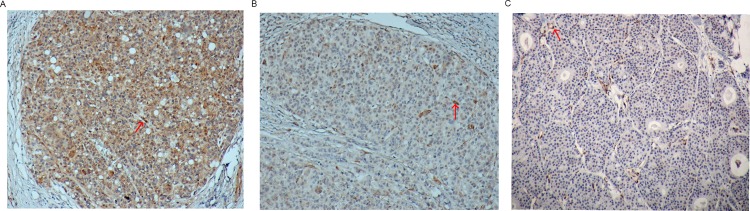
Immunohistochemistry of PTEN expression.Depicted are photomicrographs of PTEN scoring: A, score 2 = same staining intensity as of surrounding normal epithelium; B, score 1 = weaker than normal; C, score 0 = no staining (× 100). The red arrow indicated the normal tissue.